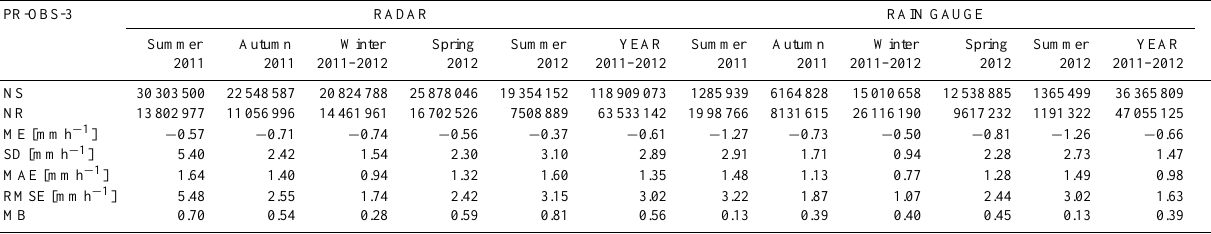
Table 13. Continuous indicators for PR-OBS-3: NS (number of considered satellite product samples); NR (number of reference field sam- ples); ME (mean error); SD (standard deviation of ME); MAE (mean absolute error); RMSE (root mean square error); MB (multiplicative bias).